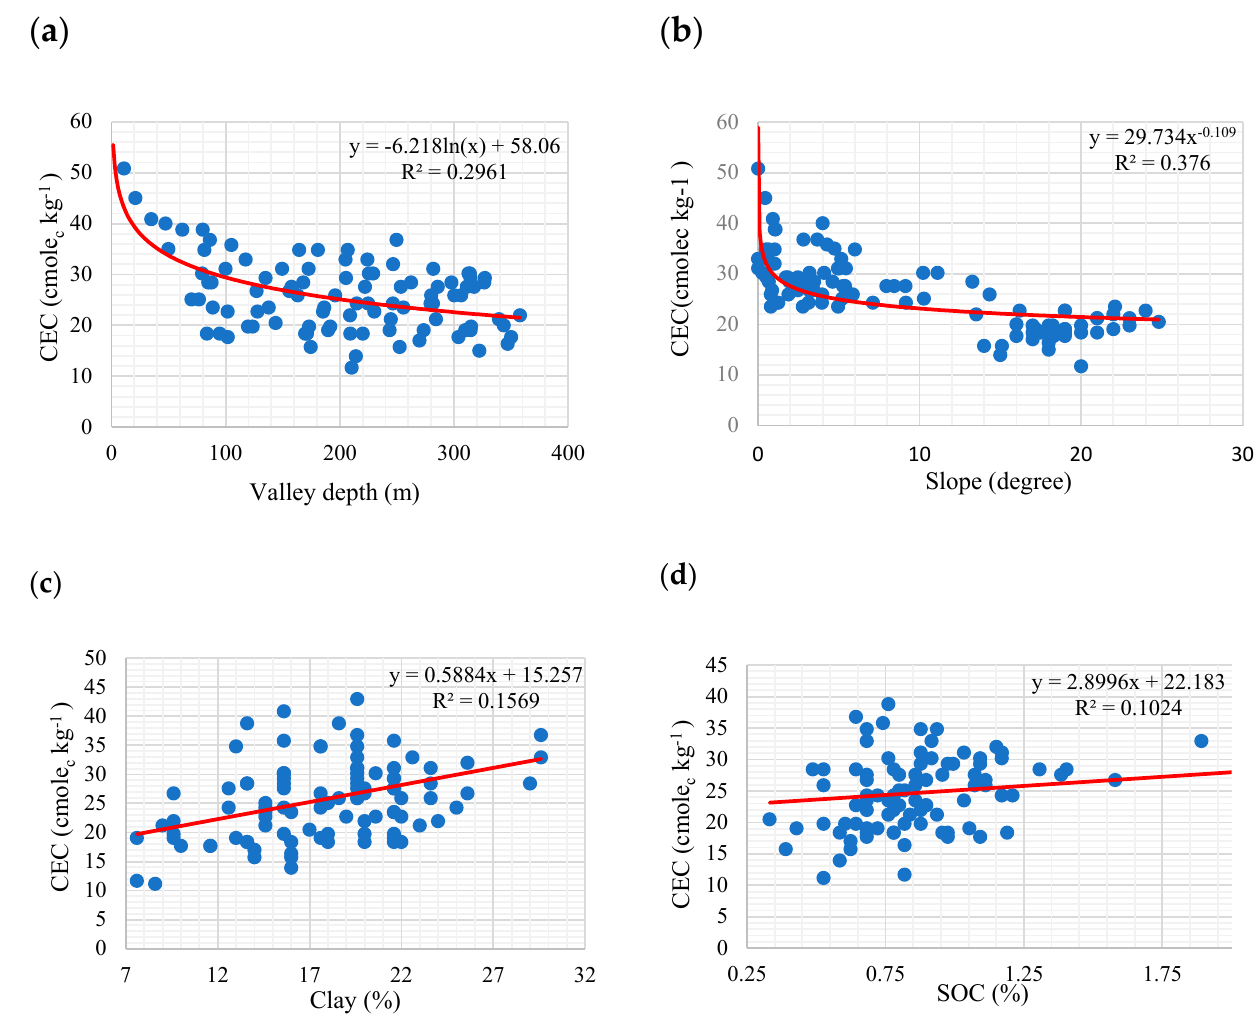
Figure 8. Relationships between some environmental variables and soil proprieties with CEC content in the study area. ( a ) valley depth vs. CEC, ( b ) slope vs. CEC, ( c ) clay vs. CEC, and ( d ) SOC vs. CEC.